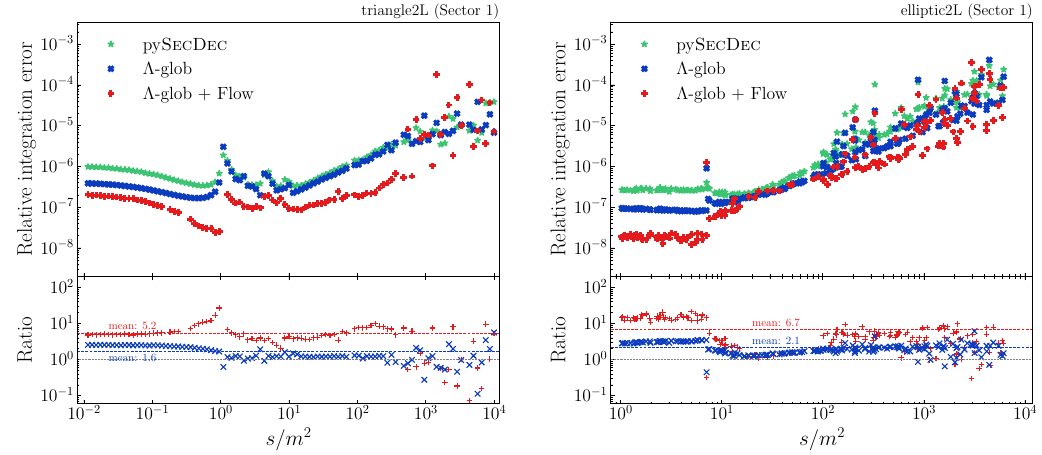
Figure 8: Relative integration error for sector one of the triangle2L (left) and el- liptic2L (right) integrals using the standard pyS EC D EC algorithm (green), the Λ -glob algorithm (blue) and Λ -glob with additional normalizing flow (red). The lower panel shows the ratios to the standard